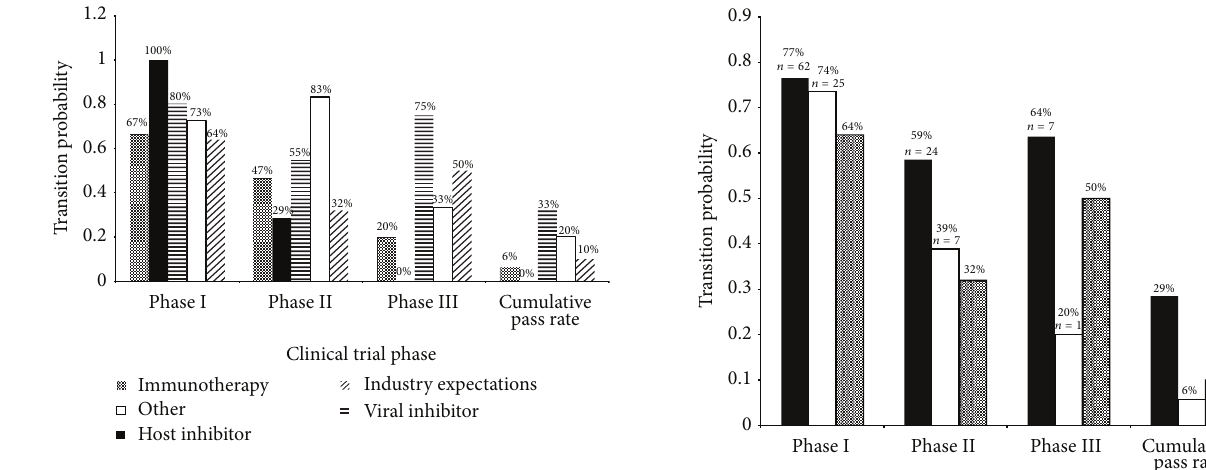
Figure 4: Success rate based on mechanism of action. The clinical trial success rates were further analyzed based on the mechanism of action of the drug compound. The four categories, immunotherapy, host inhibitors, viral inhibitors, and other, were compared against the industry expectation for the transition probability of that drug class. The cumulative pass rate indicates the overall probability that a drug from that class will be successful in all phases and achieve FDA approval.